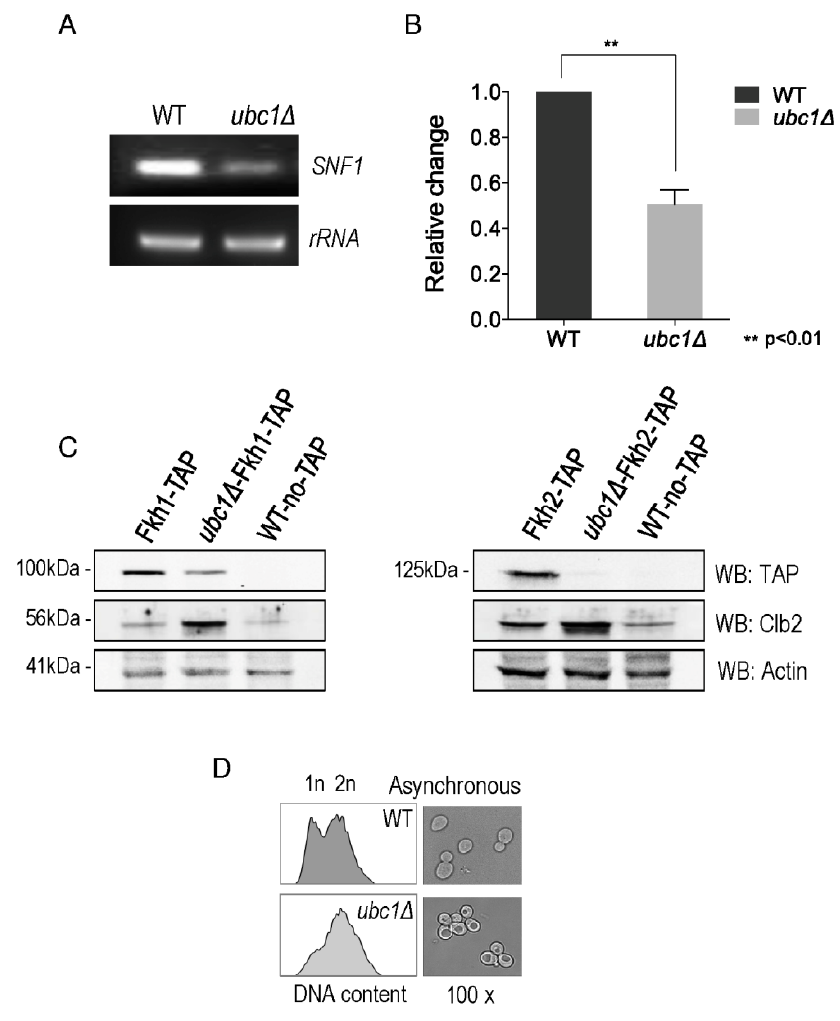
FIGURE 4: SNF1 expression and Fkh protein abundance are decreased upon Ubc1 deletion. (A) SNF1 and rRNA products from RT-PCR (26 cycles) were run on an agarose gel. RNA was isolated from isogenic WT and ubc1 Δ strains that were grown to early log phase. (B) Quantitation of three bio- logical repeats of (A) is shown with mean, SEM, and t-tailed significance (Prism 6.0). (C) The transcription fac- tors Fkh1 and Fkh2 were endogenously TAP-tagged within the WT and ubc1 Δ strains, and steady-state protein levels in 2% glucose (Fkh1-TAP left panel, 15 μg/lane, and Fkh2-TAP right panel 80 μg/lane) assessed by Western analysis. Clb2 is detected endogenously. (D)